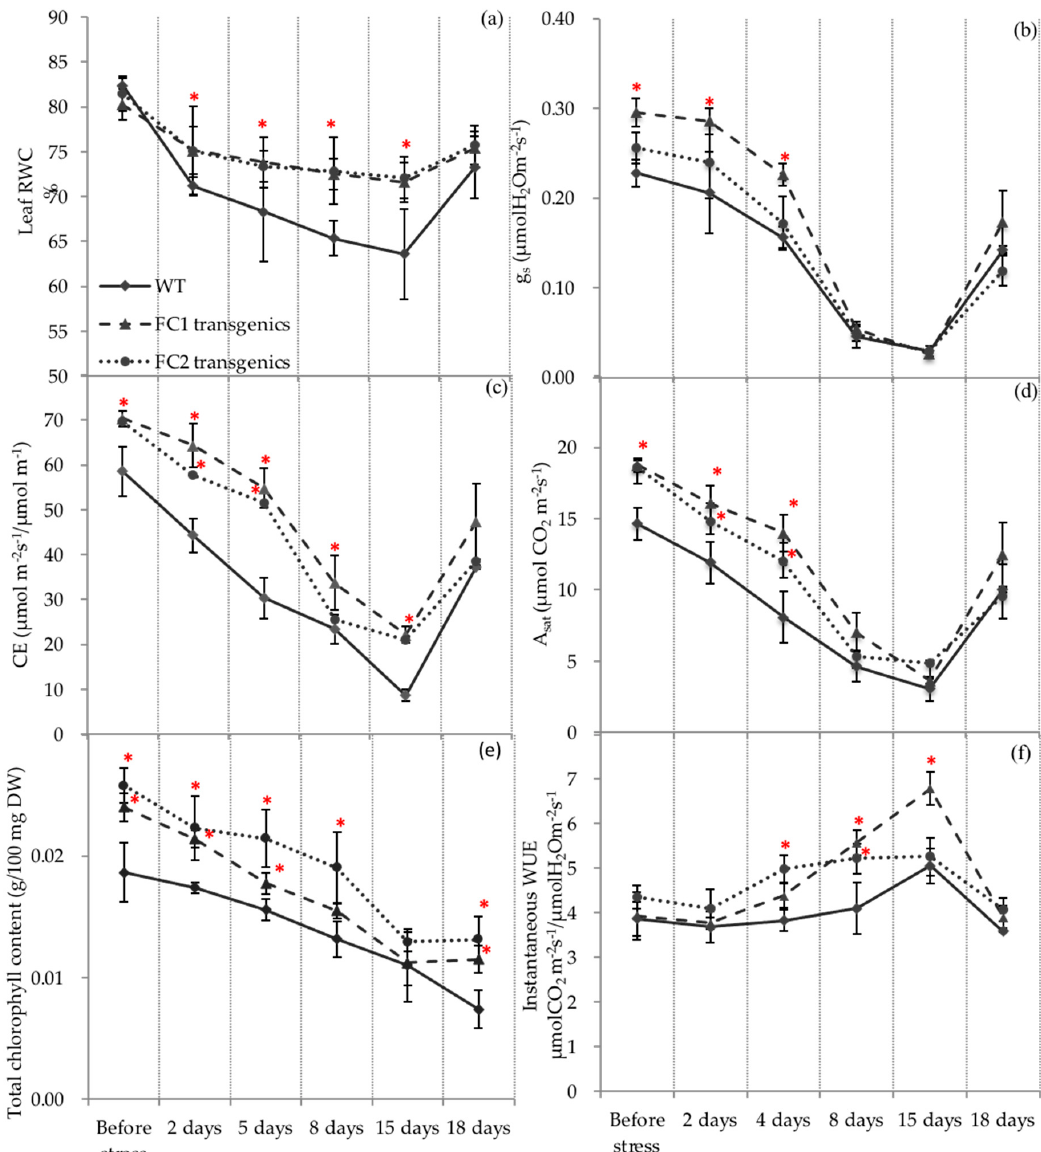
Figure 4. HvFC overexpressing transgenics maintained higher leaf water status and photosynthetic performance relative to controls upon drought. Physiological traits measured include—( a ) leaf relative water content (RWC), ( b ) stomatal conductance, ( c ) instantaneous carboxylation efficiency, ( d ) carbon assimilation rate, ( e ) total chlorophyll content, and ( f ) instantaneous water use efficiency (WUE) relative to wild-type (WT) control plants upon drought stress. The data are shown as mean ± standard error (SE) of five plants for each of the three independent transgenic lines, per construct and WT. Asterisks indicate a statistically significant difference between the transgenics and controls, at * p < 0.05 based on two-way ANOVA.